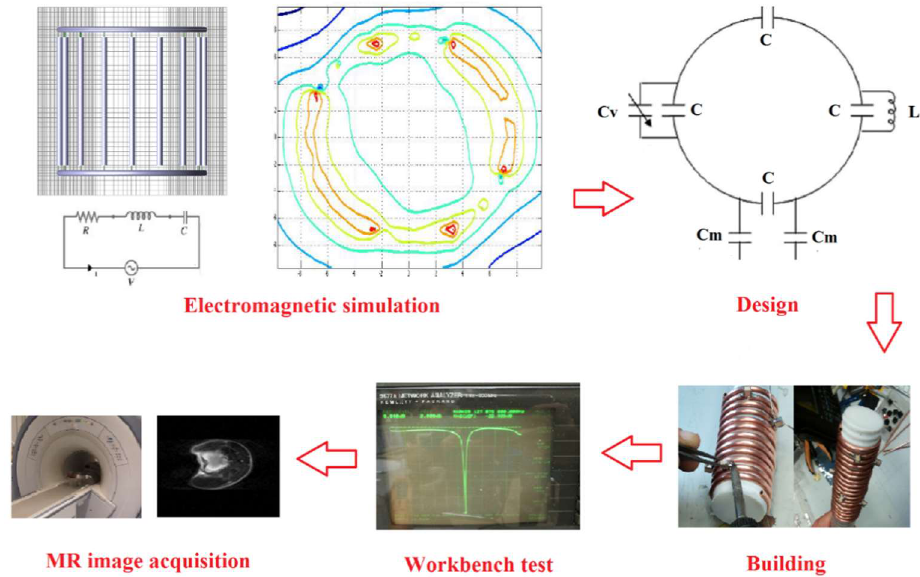
Figure 4. The different phases in the radiofrequency (RF) coil development.